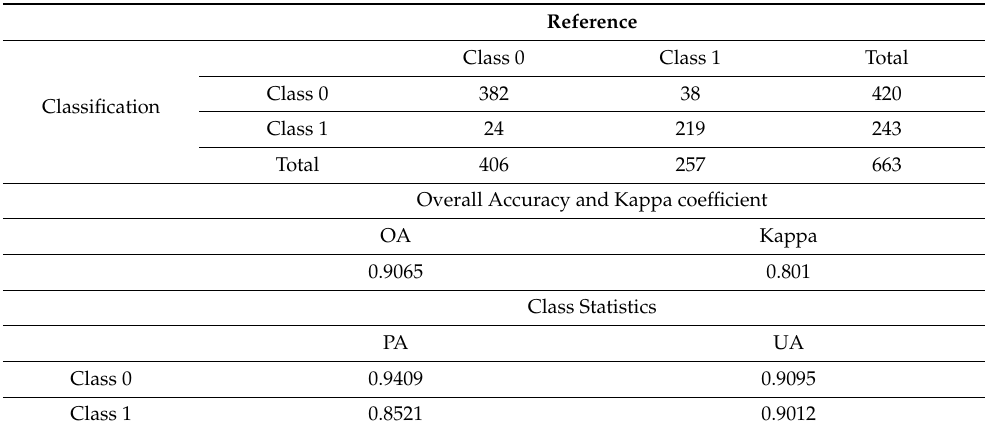
Table A10. S2 + GLCM MAX + Topo + CHM classification (“scheme